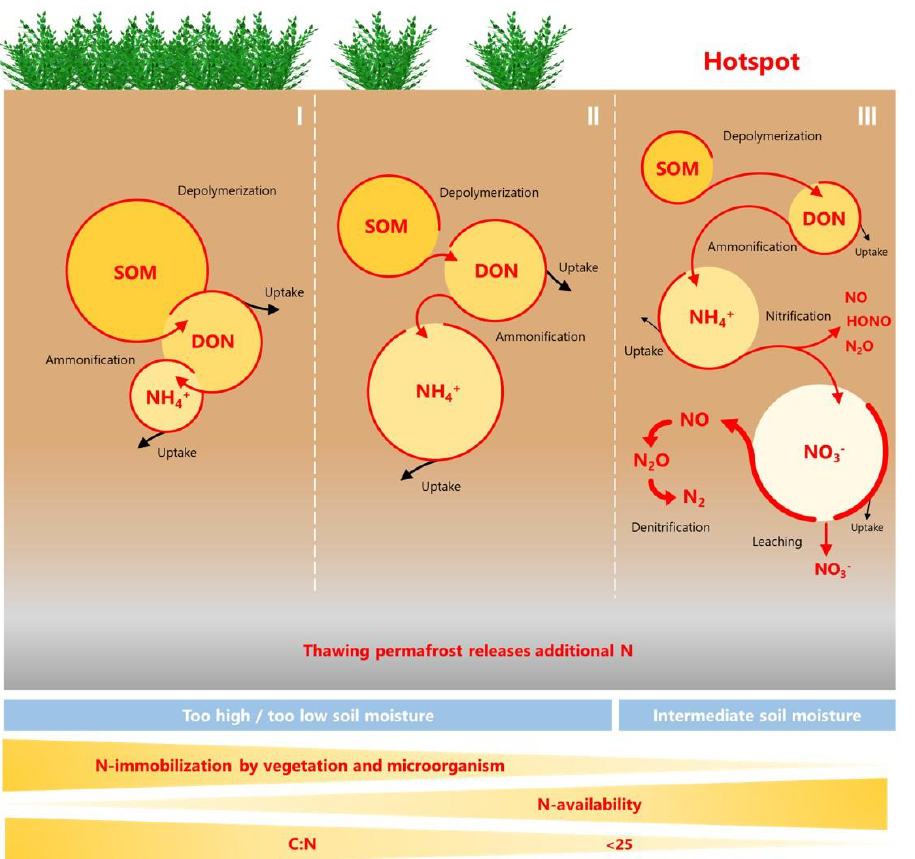
Figure 2. Levels of N availability in permafrost-affected soils. ( I ) N limitation level with tight, mainly organic N cycle dominated by depolymerization and zero or negative net N ammonification